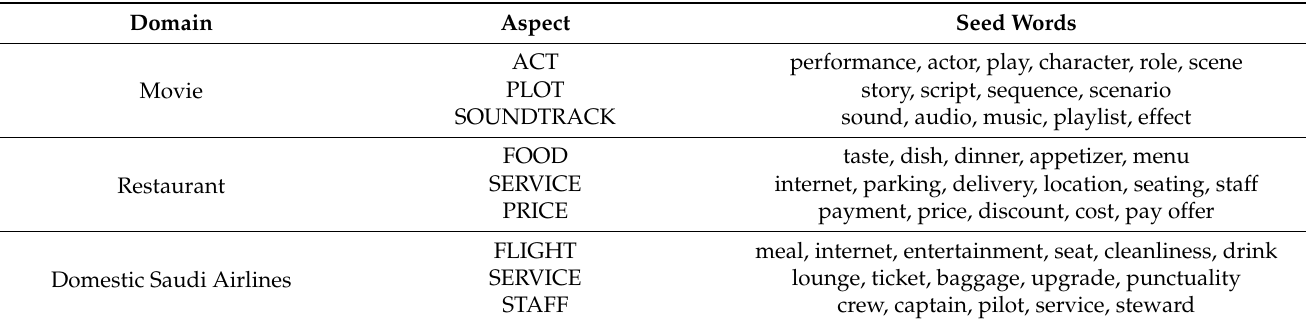
Table 2. Aspects and seed words for each